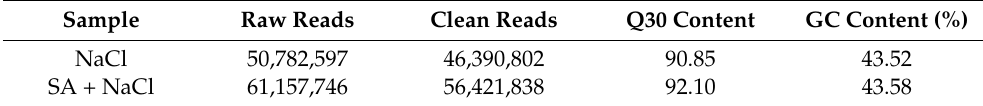
Table 2. Statistics of SA-mediated transcriptome sequencing of melon in response to salt stress.